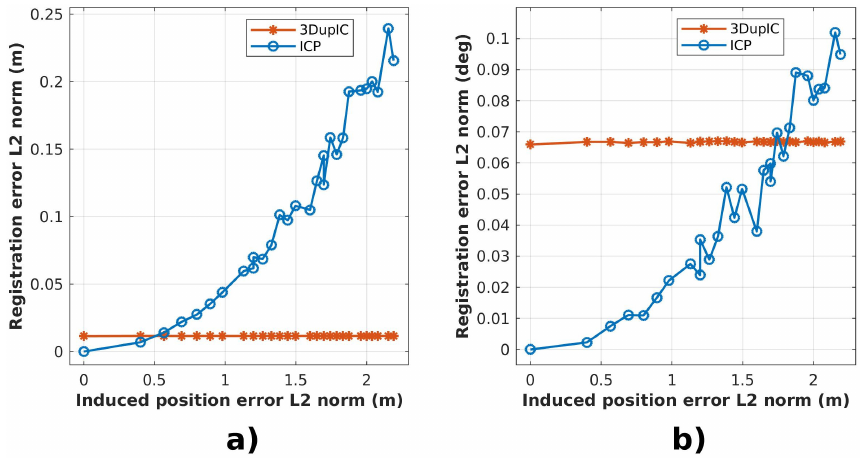
Figure 4. Relation between the final registration errors, expressed through the Euclidean distance of ( a ) position and ( b ) orientation registration errors, with respect to the norm of the position distur- bance introduced initially to each registration method. The vertical axis corresponds to the average registration error, computed from the experiments executed for each sampled disturbance distance.